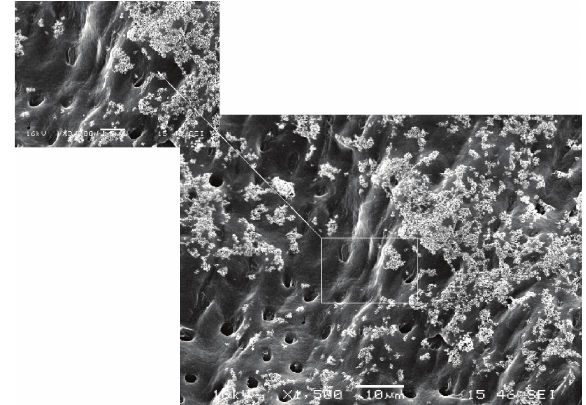
Figure 1: SEM ( × 500) showing dentin surface of the specimens in the control group. At higher magnification ( × 3000) intact smear layer can be observed.